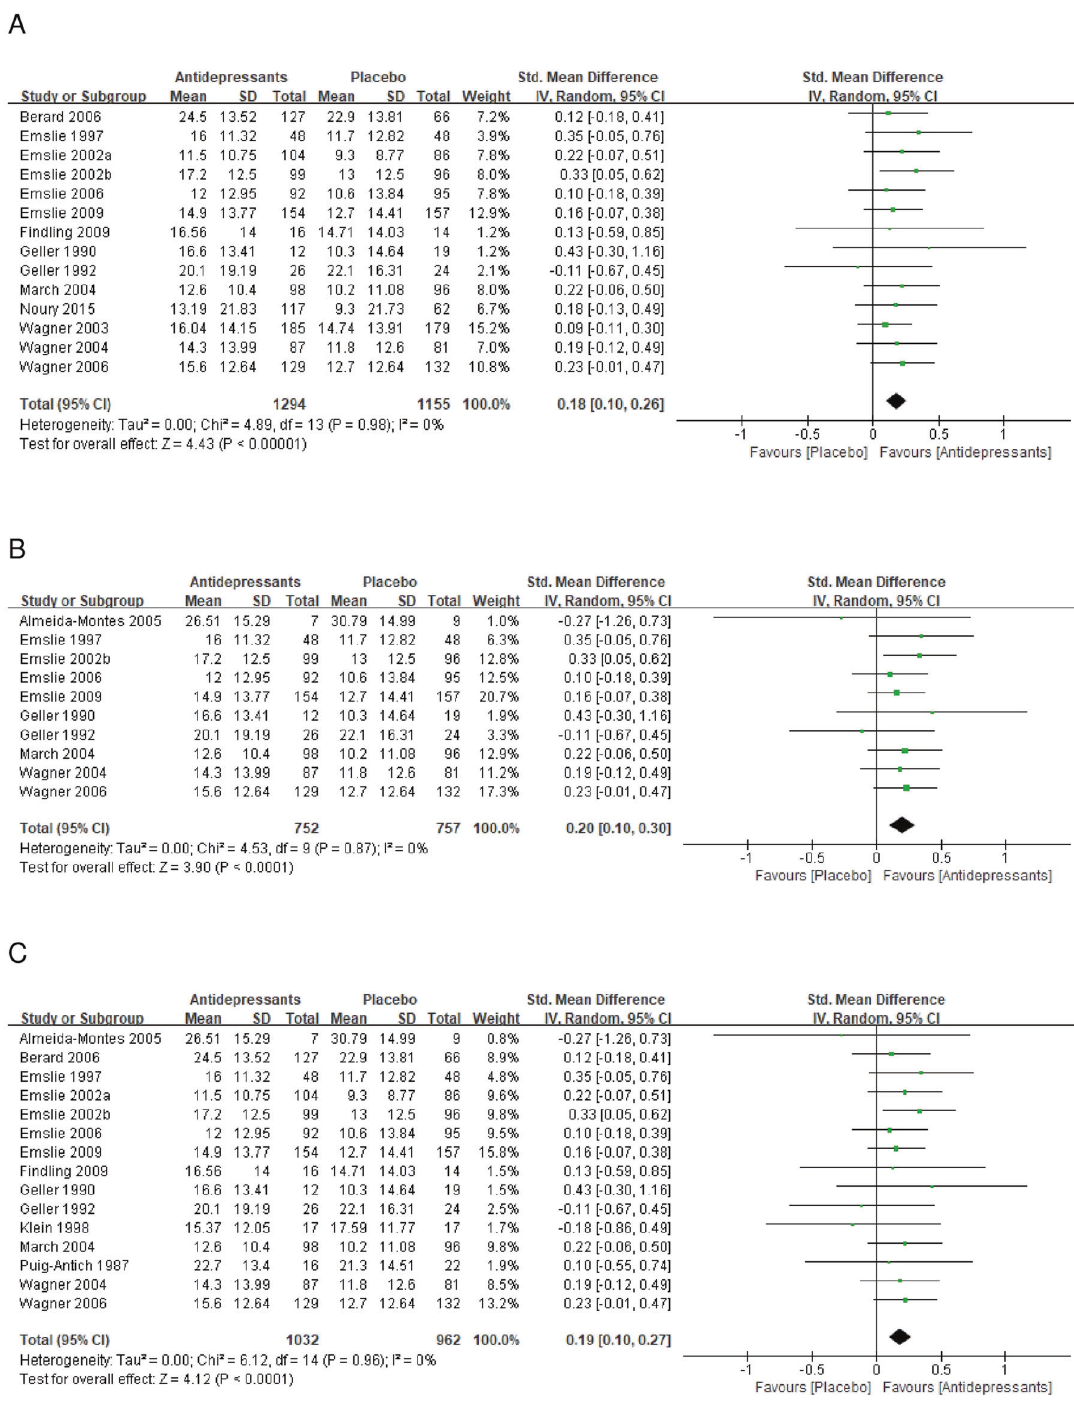
the SMD of the change in functioning scale scores for the comparison between antidepressants and placebo when excluding studies allowing concurrent psychotherapy during treatment. C Forest plot of the SMD of the change in functioning scale scores for the comparison between antidepressants and placebo when excluding studies using self-rated scales. SD standard deviation, CI con fi dence